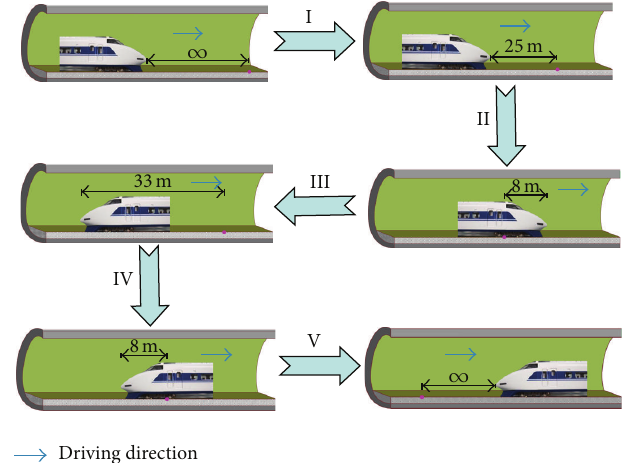
Figure 13: Various periods corresponding to the running position of the